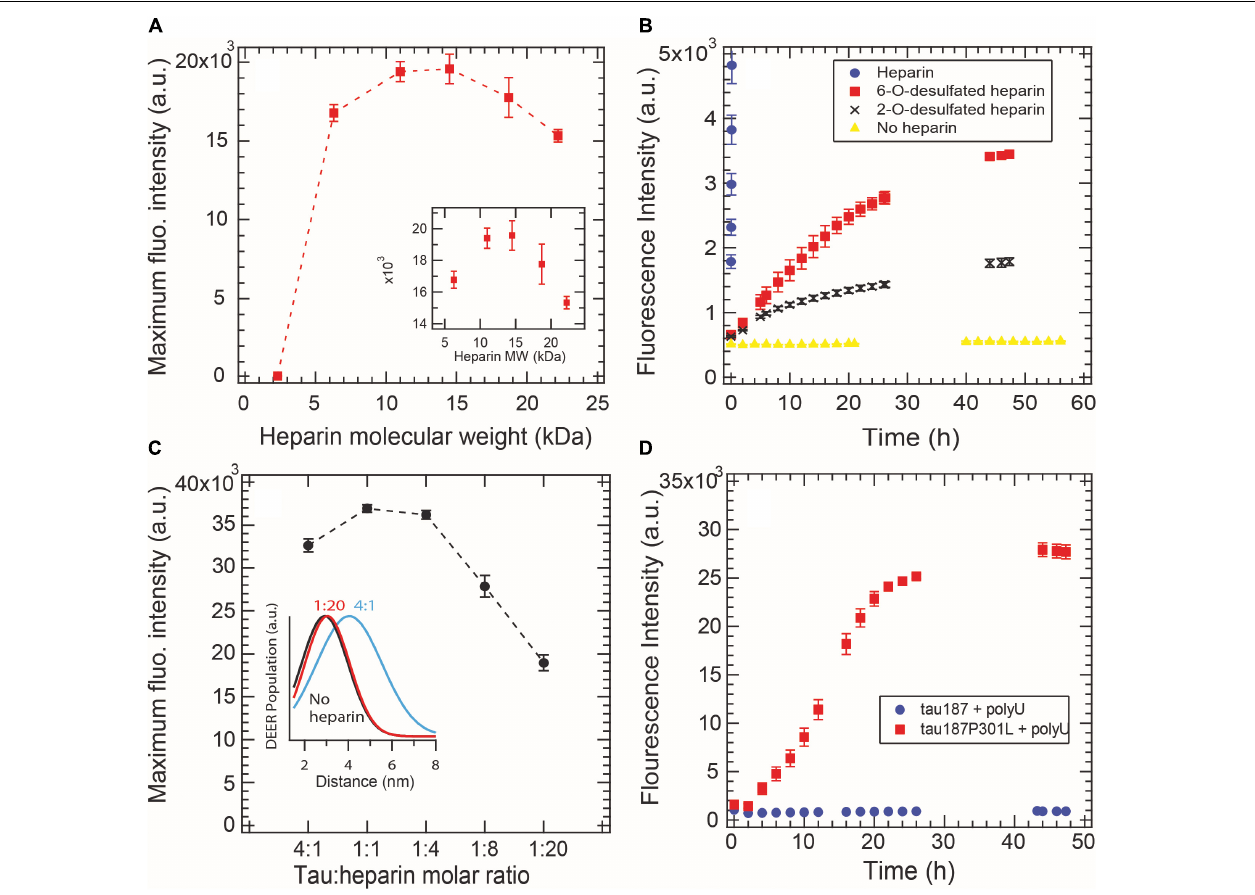
FIGURE 5 | Cofactor length, stoichiometry, charge state and nature modulate tau187 aggregation, as probed by ThT fluorescence. ThT fluorescence was measured over time and the maximum plateau value is plotted for (A) different heparin lengths (constant mass ratio) and (C) different tau:heparin molar ratios. DEER distance distribution between residues 272 and 285 (inset C ) shows that S ∗ is not present at 1:20 tau:heparin ratio, (B) Tau187 was incubated with fully sulfated (purple circle), 6-O desulfated (red square), 2-O desulfated (black cross) heparin or no heparin (yellow triangle) at 4:1 tau:heparin ratio. The sulfated heparin curve converges to about 3.8 × 10 4 fluorescence units and was cut to better highlight the difference between 6OD and 2OD. (D) PolyU (500 µ g/mL) incubated with tau187 and tau187-P301L. The protein concentration was 50 µ M in all panels. Gaps in the ThT kinetics (B,D) originate from reading interruptions. Error bars represent standard deviation over 3